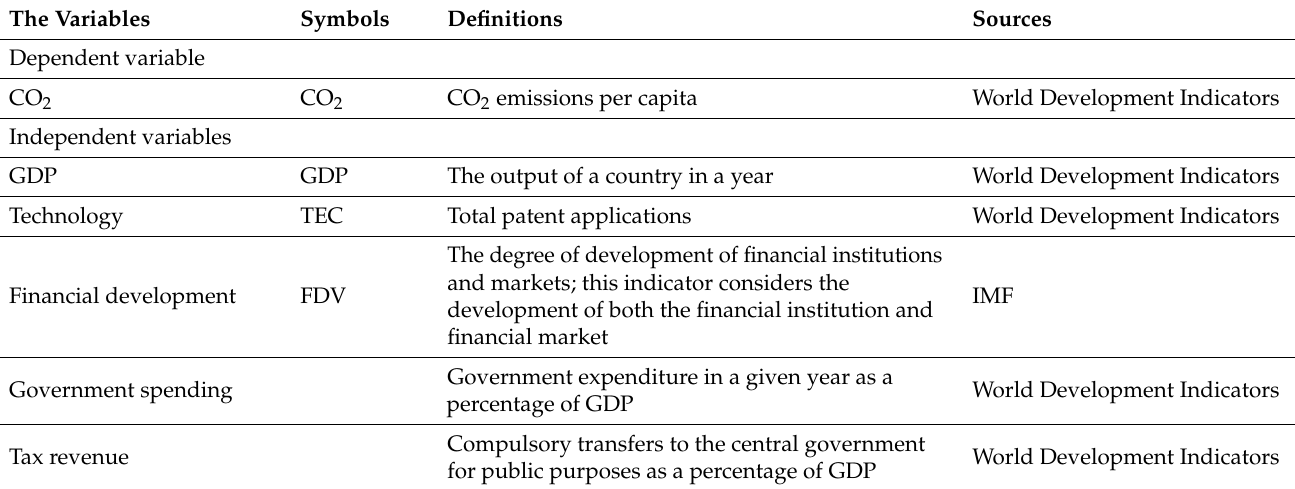
Table 2. Descriptions and source of the